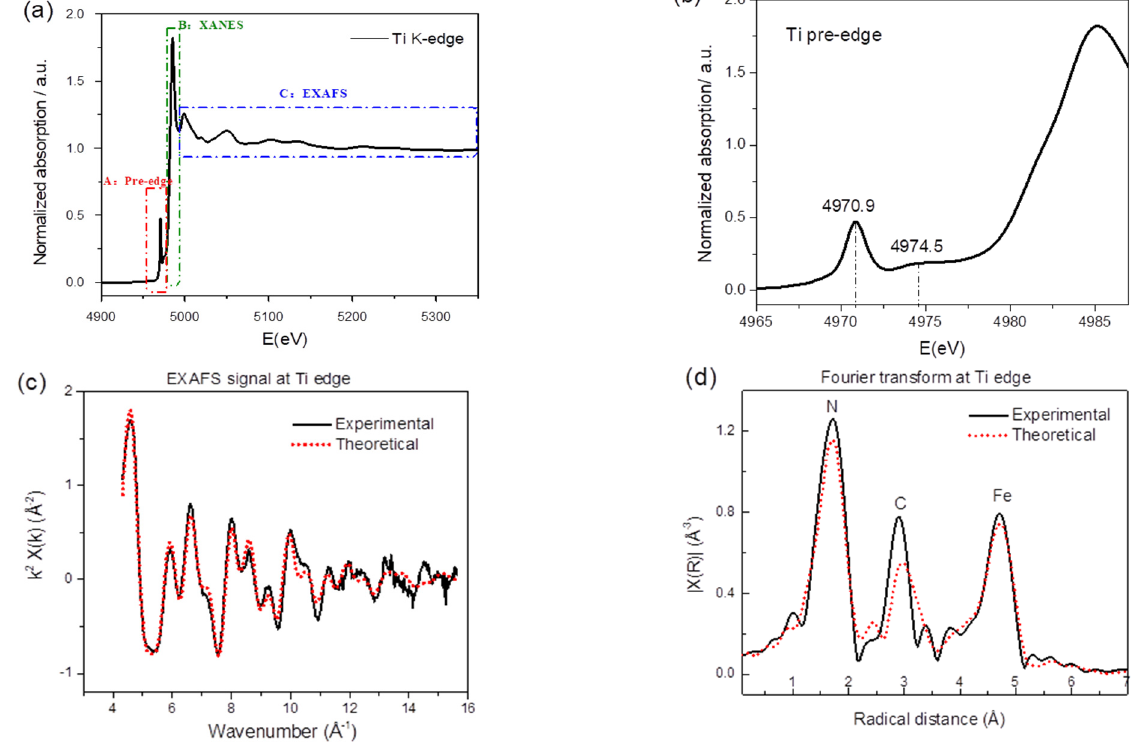
Figure 2. ( a ) Normalized X-ray absorption spectrum of TiHCF powder at the titanium K-edge. ( b ) Zoom-in of the pre-edge feature of Ti K-edge. ( c ) Comparison of the experimental and theoretical k 2 -extracted EXAFS (extended X-ray absorption fine structure) signal and ( d ) corresponding Fourier transform (FT).